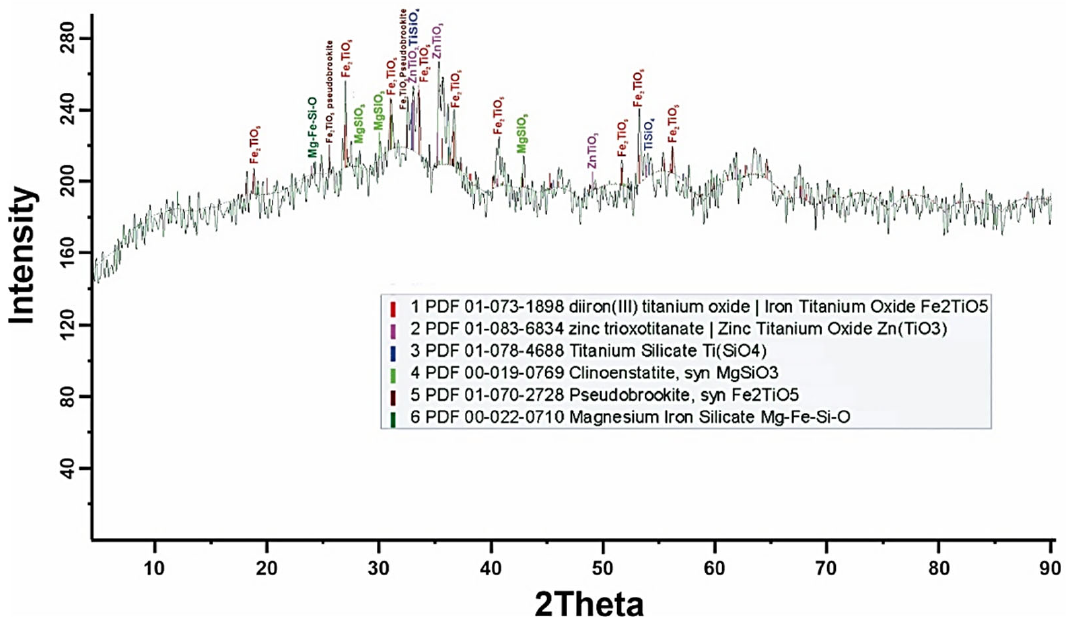
Figure 1. Diffraction pattern of electric smelting dust of ilmenite concentrate. Analysis methods: X ‐ ray diffraction analysis was performed on a D8 ADVANCE “BRUKER AXS GmbH” diffractometer (Karsruhe, Germany), Cu ‐ K α emission. The data ‐ base PDF ‐ 2 International Center for Diffraction Data ICDD (Swarthmore, PA, USA) was used.